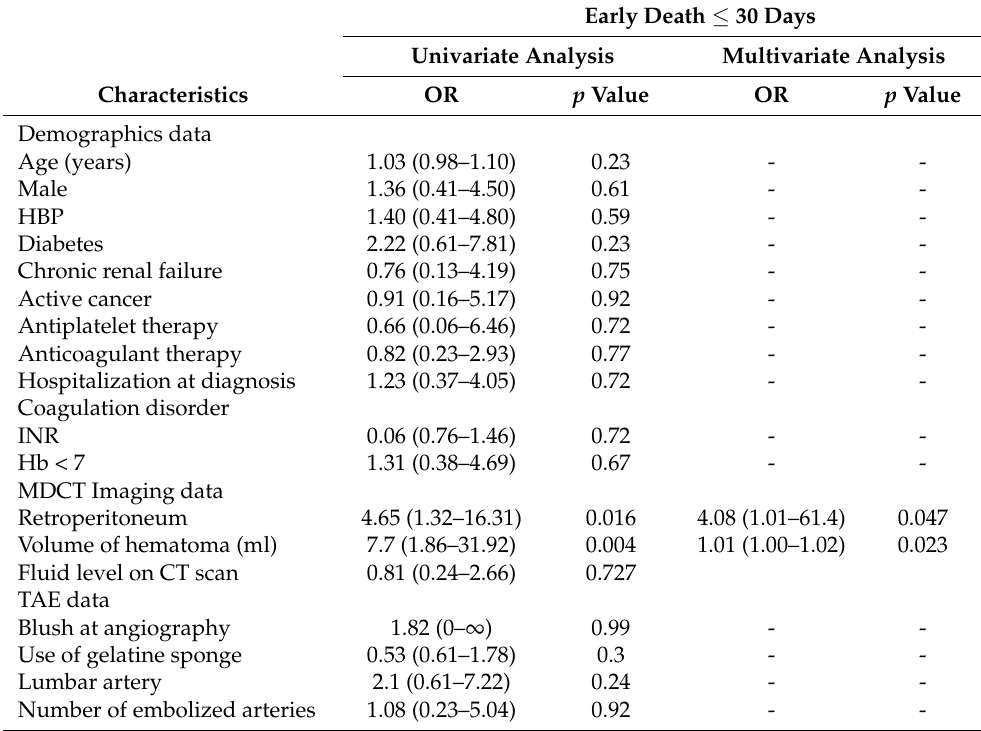
Table 5. Univariate and multivariate regression analysis for early death.